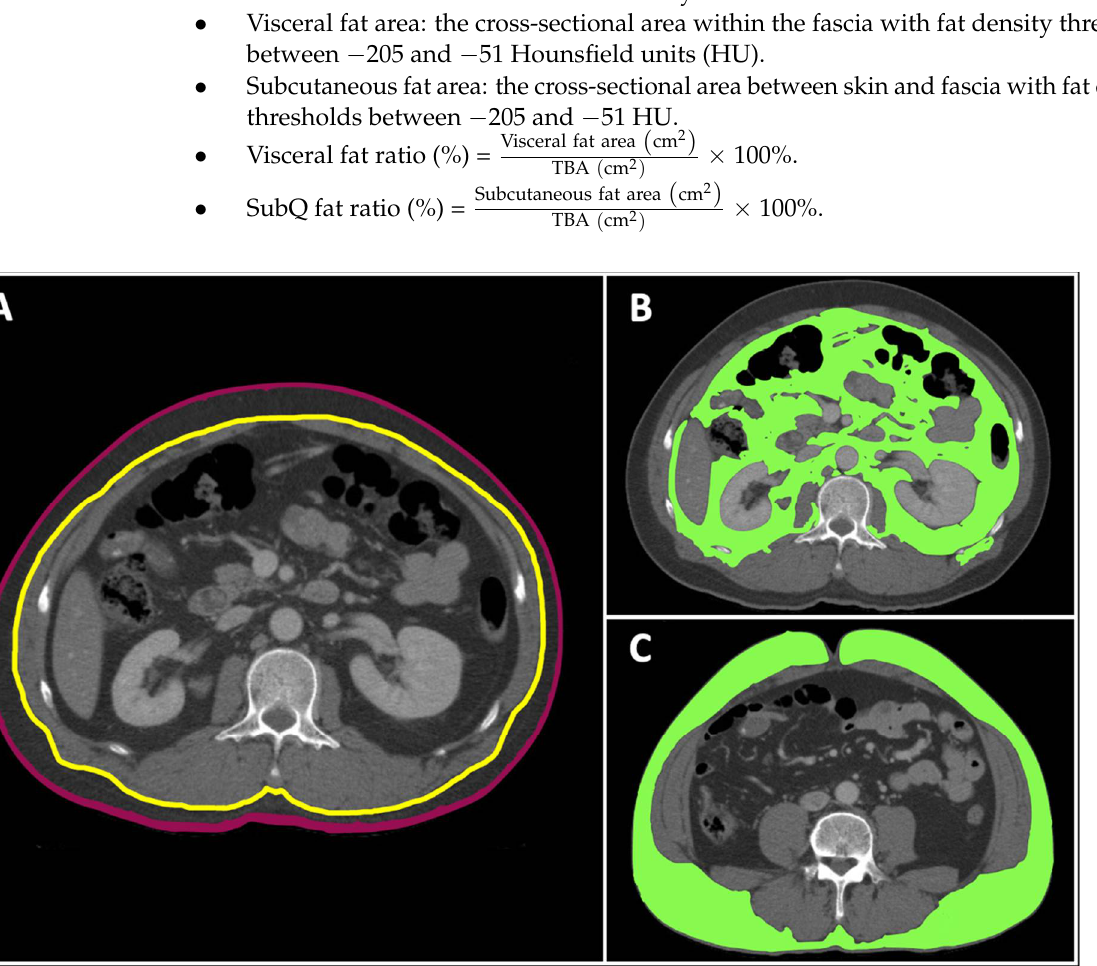
Figure 1. This figure demonstrates the morphomic variable measurements of a 53-year-old male motorcyclist by a CT scan. Total body area was measured by the cross-sectional area inside the purple line ( A ), whereas the visceral fat area (at the L2 vertebral level) was represented by the area inside the fascia (yellow line) meeting fat density thresholds ( B ), and the subcutaneous fat area (at the L4 vertebral level) was represented by the area between the skin and fascia meeting fat density thresholds ( C ).